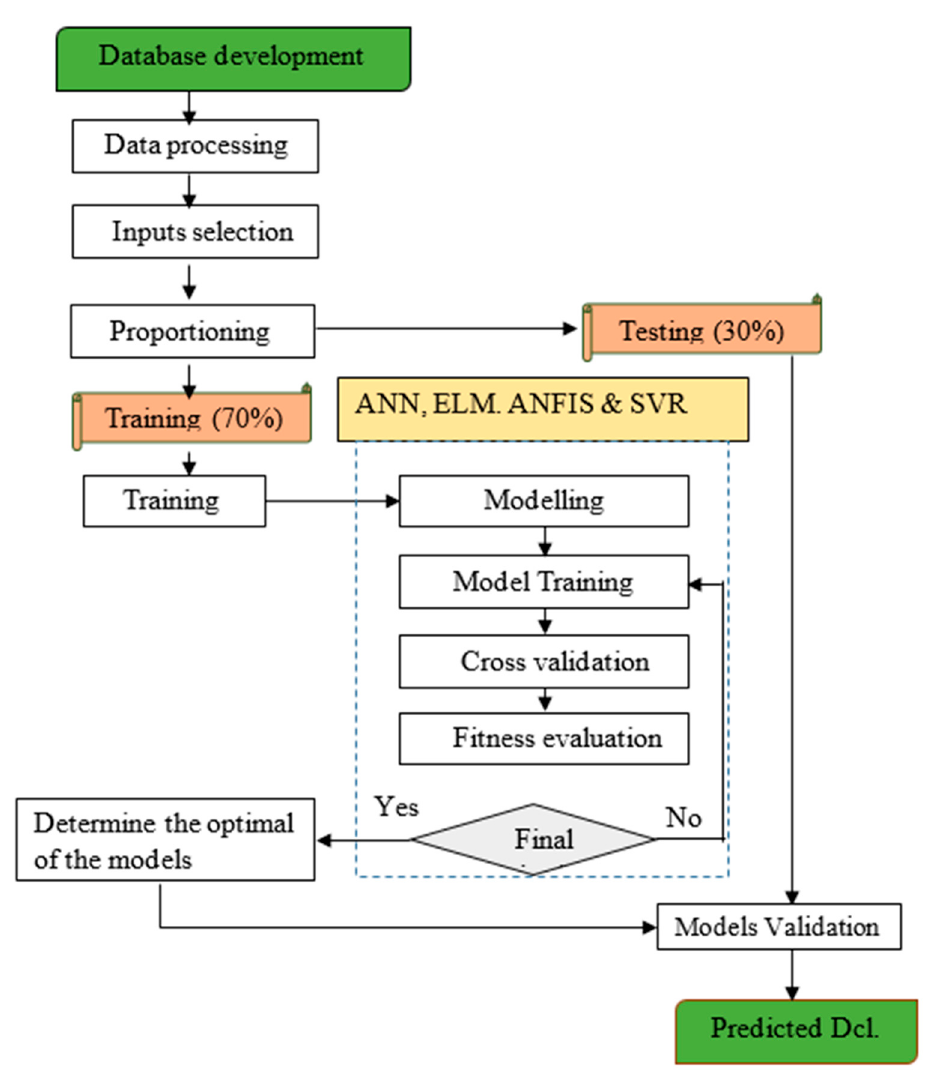
Figure 3. The flowchart of the developed models.